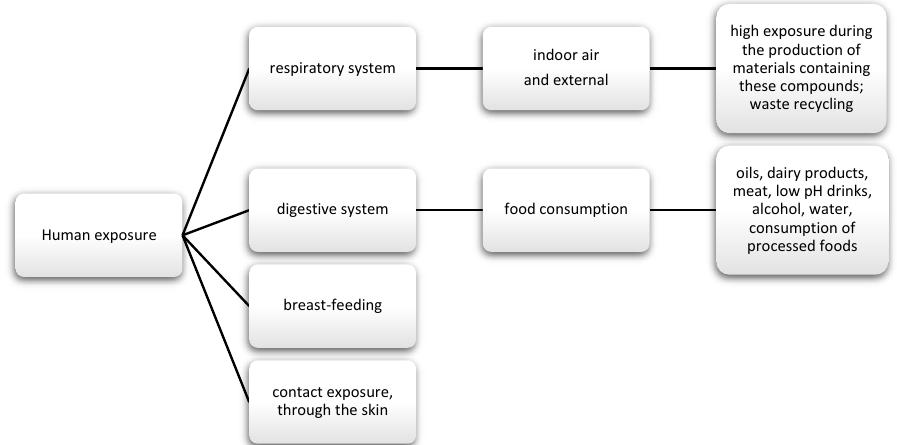
Figure 3. Main routes of exposure to phenols and phthalates.